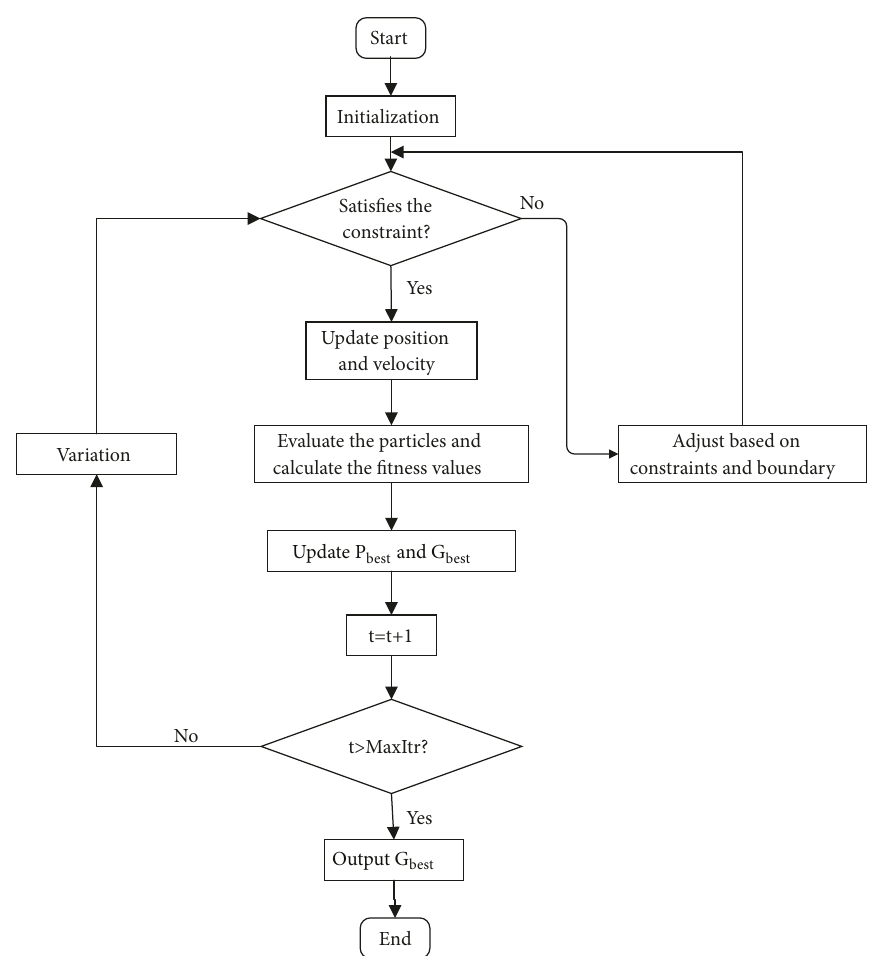
Figure 4: Particle swarm optimization